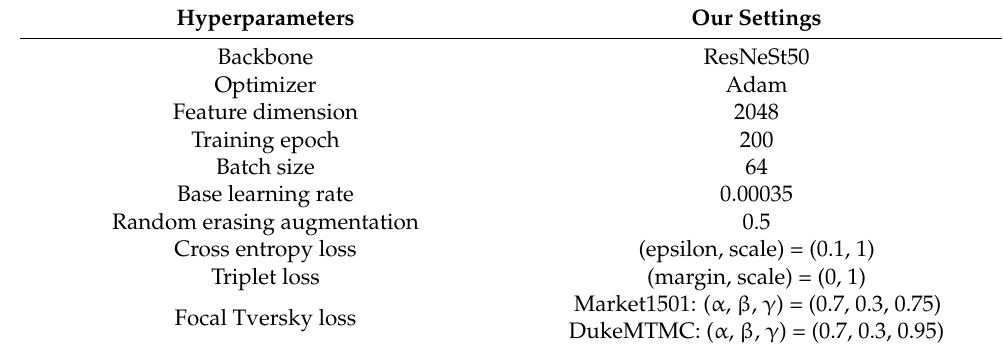
Table 1. Hyperparameters of the proposed